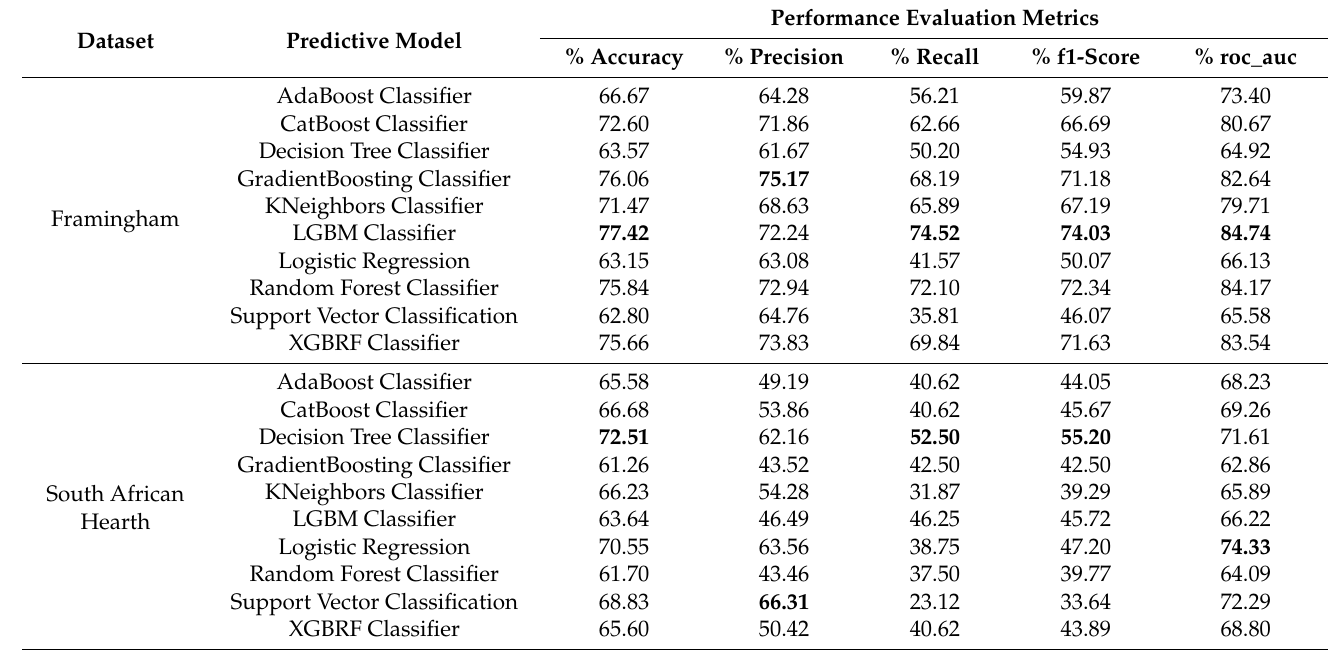
Table 10. K-fold cross-validation analysis of ten ML classifiers on top-two Framingham and South African dataset attributes.